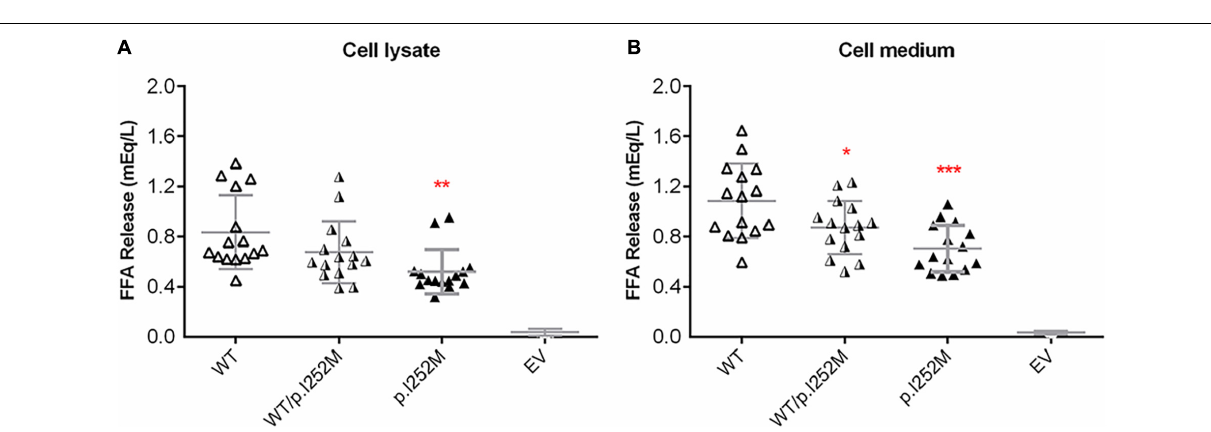
FIGURE 5 | Western blot analysis of post-heparin LPL expression in cell lysates (A) and media (B) of transfected HEK293T cells. Results were the average taken from three independent experiments. LPL, lipoprotein lipase; WT, wild-type; EV, empty vector.